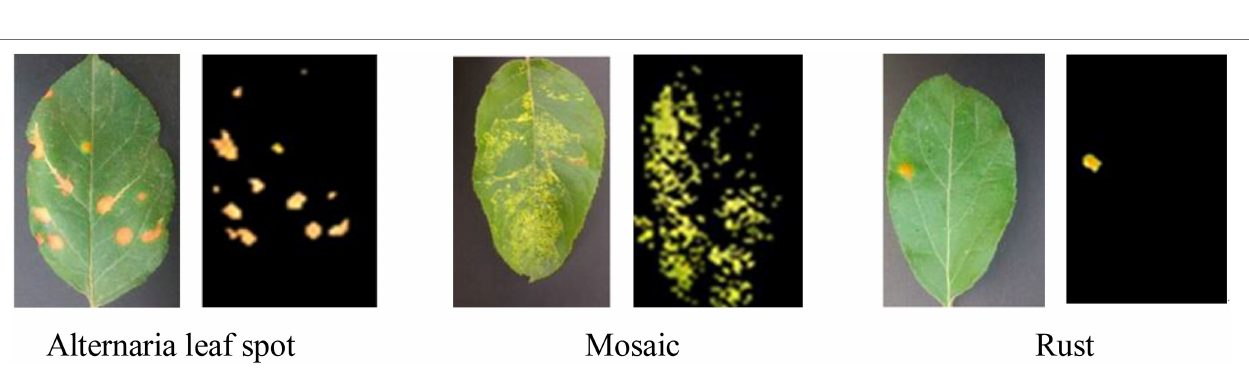
FIGURE 7 | Apple diseased leaf images and corresponding segmented lesion